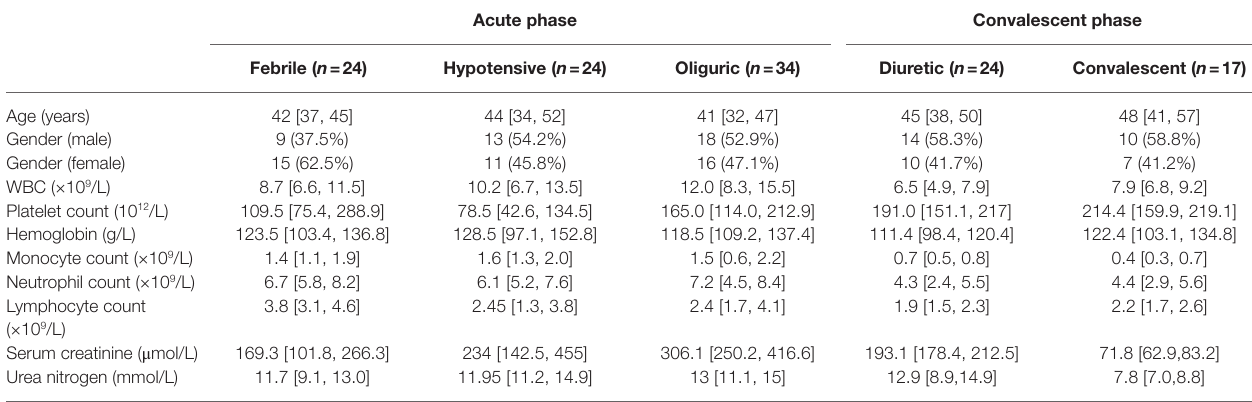
TABLE 2 | Clinical and laboratory features of patients with HFRS stratified by five